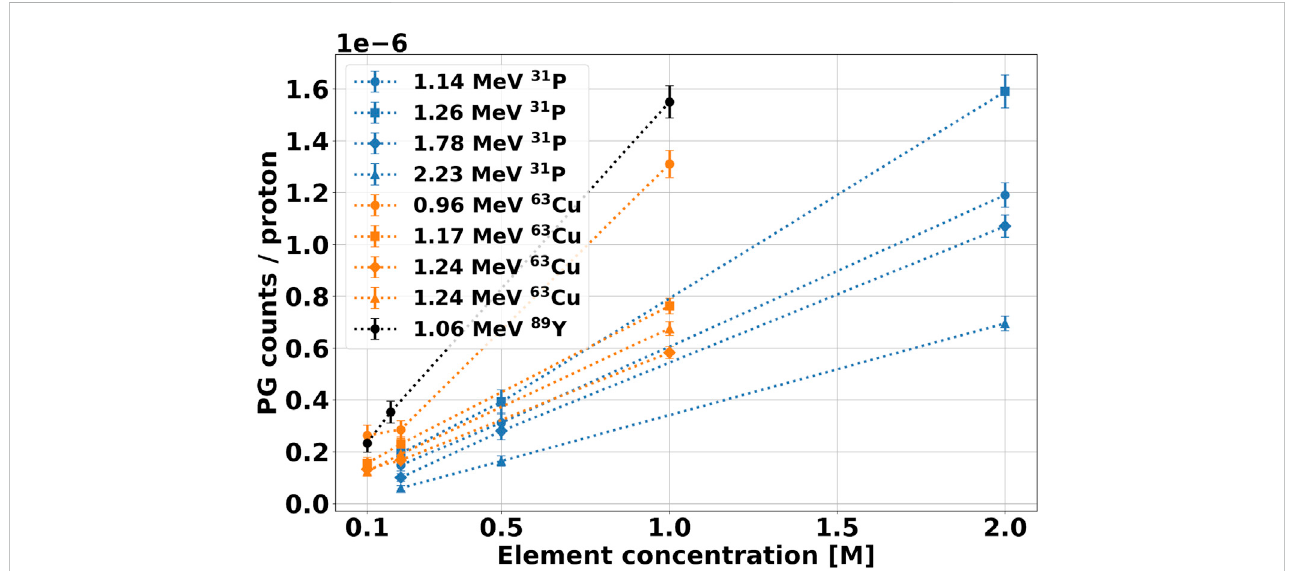
FIGURE 9 Yield of signature gammas as a function of the element molar concentration in the solution after irradiation with 70 MeV protons. The PG counts have beencalculatedfromtheintegrationofthecorrespondingpeakinthespectraofFigure8.Thebackgroundcontributionfromwaterhasbeensubtractedfrom the spectrum, and the results have been normalized to the number of protons incident on the